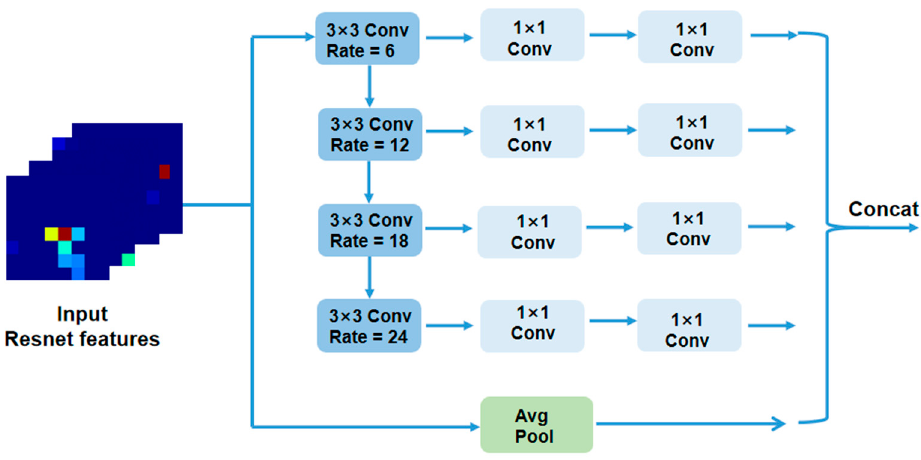
Figure 5. Structure of the WASP